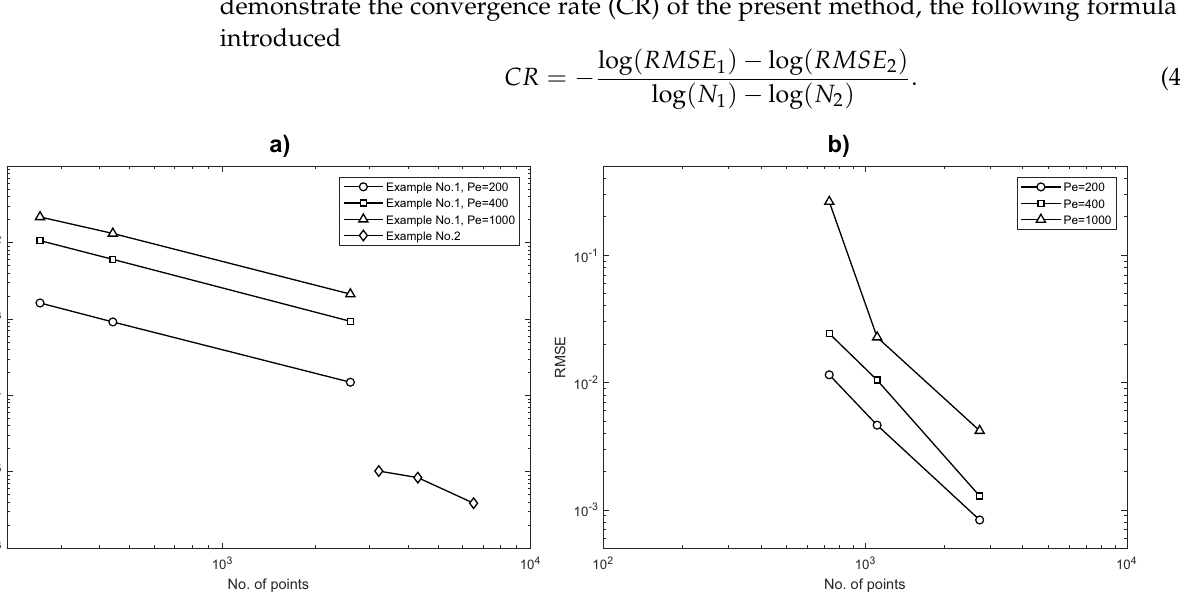
Figure 18. Connection of the RMSE and number of points: ( a ) steady solution, ( b ) unsteady solution. Table 12 contains values of RMSE and convergence rates for examples of the steady case and Table 13 for those of the unsteady